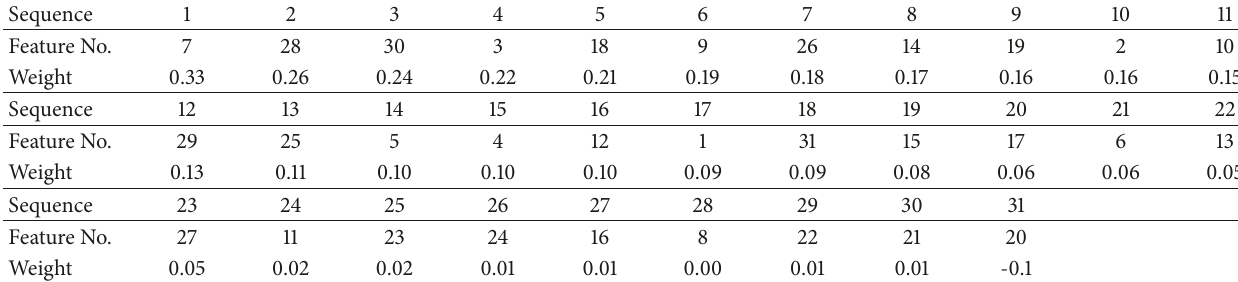
Table 9: Feature ranking of the classification